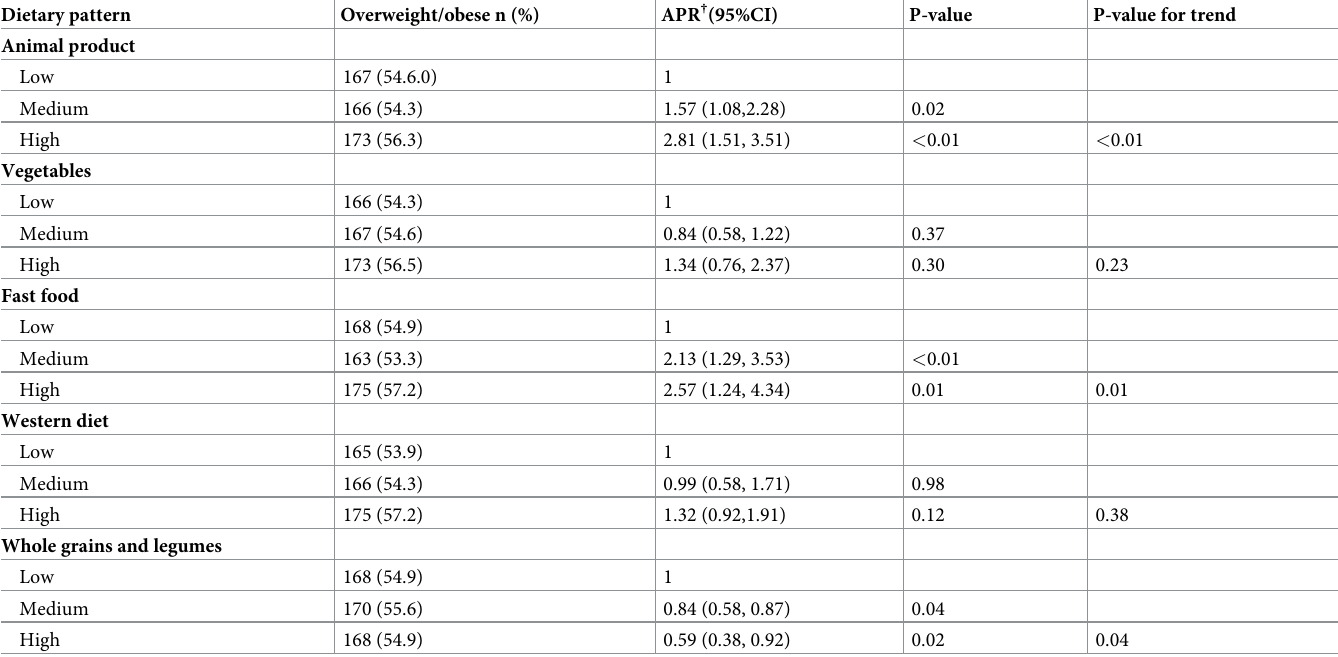
Table 5. Association between dietary patterns with overweight and obesity (N = 918). Dietary